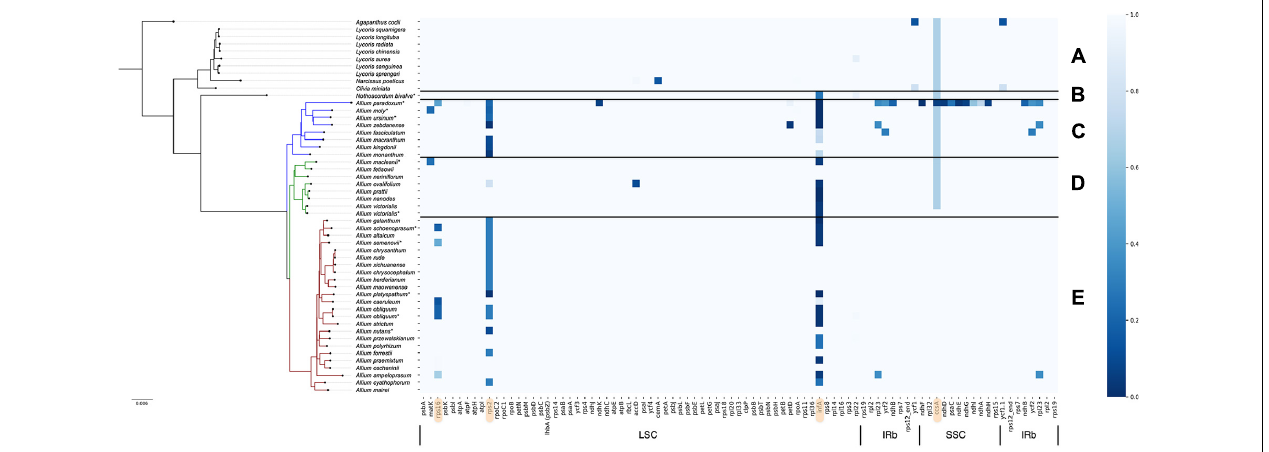
FIGURE 1 | Pseudogenization or loss of protein-coding genes heatmap in the plastome of Allioideae (including all three evolution lines of Allium ). Taxonomic position of species is denoted at the left side. Species sequenced by our group are marked with (*). (A) Shows Agapanthoideae and Amaryllidoideae subfamily species; (B) shows Nothoscordum bivalve as an outgroup for Allium genus; (C) shows the first evolutionary line Allium species; (D) —the second and (E) —the third. Genes are sorted in natural order in plastid. LSC , large single-copied region; SSC , small single-copied region; IRa and IRb , inverted repeats A and B. The darkest blue marks completely deleted genes; skyblue of varying shades marks pseudogenized genes (depending on the length of the preserved gene fragment); light blue marks true genes (translated without errors). Genes described below in detail are marked with peach color ( rps16 , rps2 , infA , ccsA